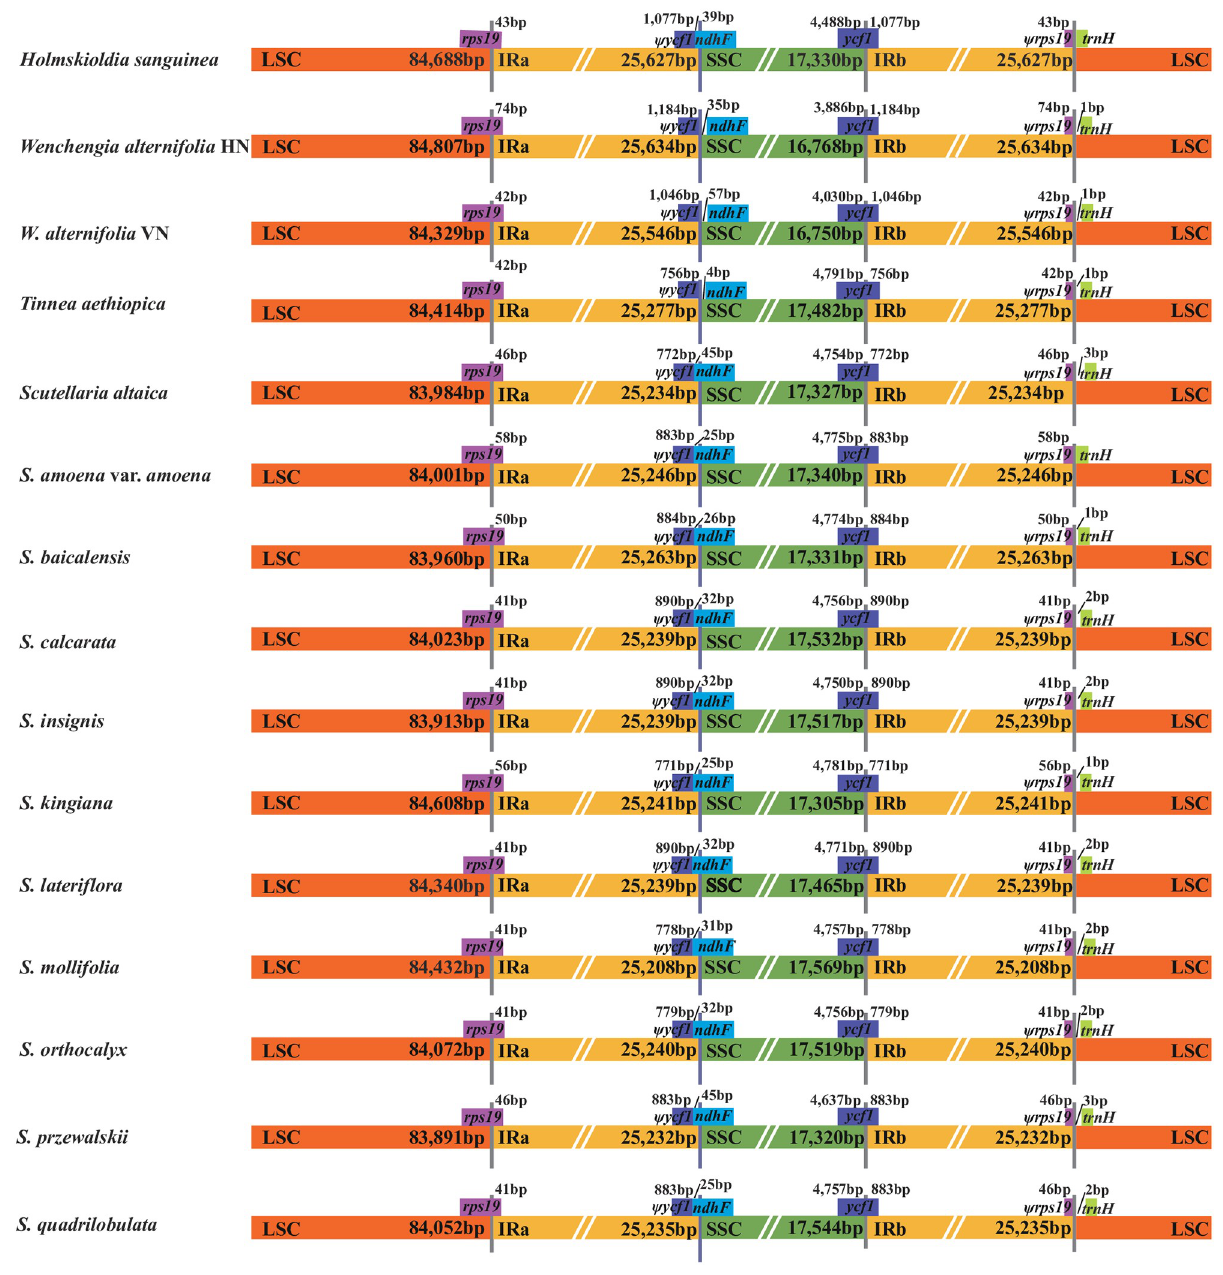
Fig 6. Comparisons of the LSC, IR, and SSC borders of plastomes of Scutellaria and related genera.